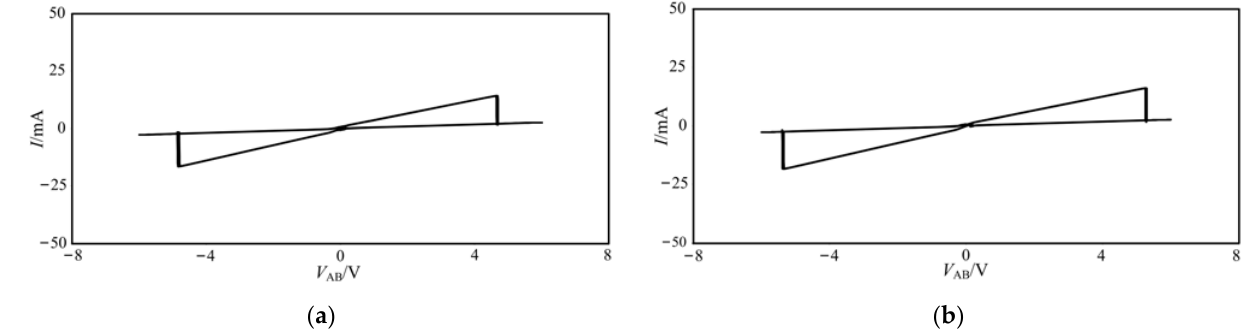
Figure 5. The i ‐ v characteristic curve of the improved hysteresis circuit: ( a ) when V + = − V − = 2 V, ( b ) when V + = − V − = 6 V.